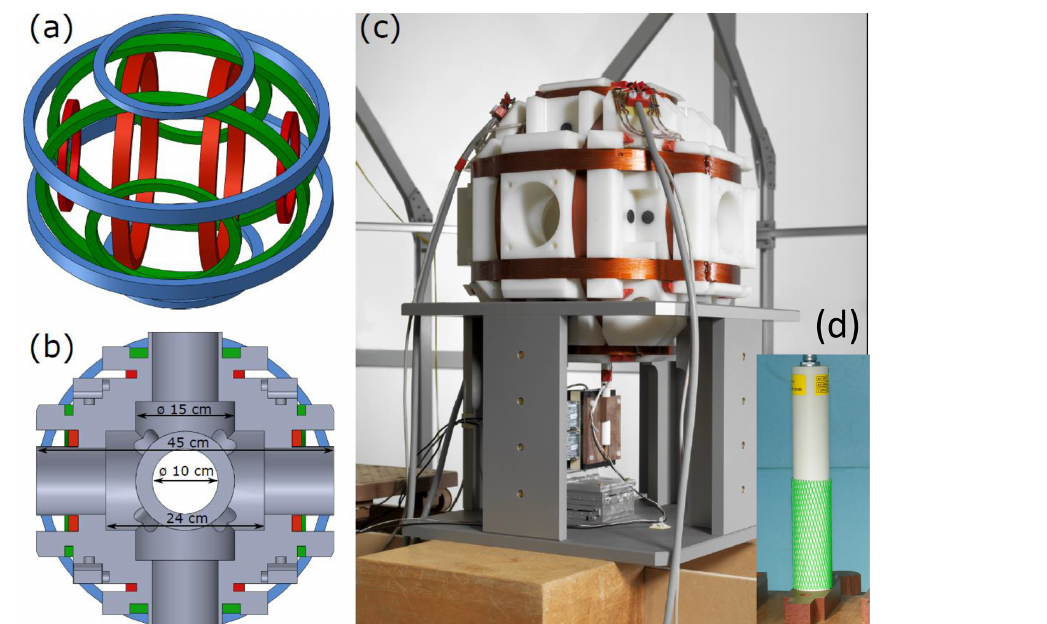
Figure 1. 3D compact coil system based on two split-pair coils with (a) showing a sketch of the winding packages labeled in red, blue and green for different axes. A technical drawing of the coil frame including inner dimensions for experimental space is presented in (b) . A picture of the final 3D coil system including holder and translation stages for sensor movement below the frame is shown in (c) . Inset (d) shows the 3D fluxgate sensor for field characterization.